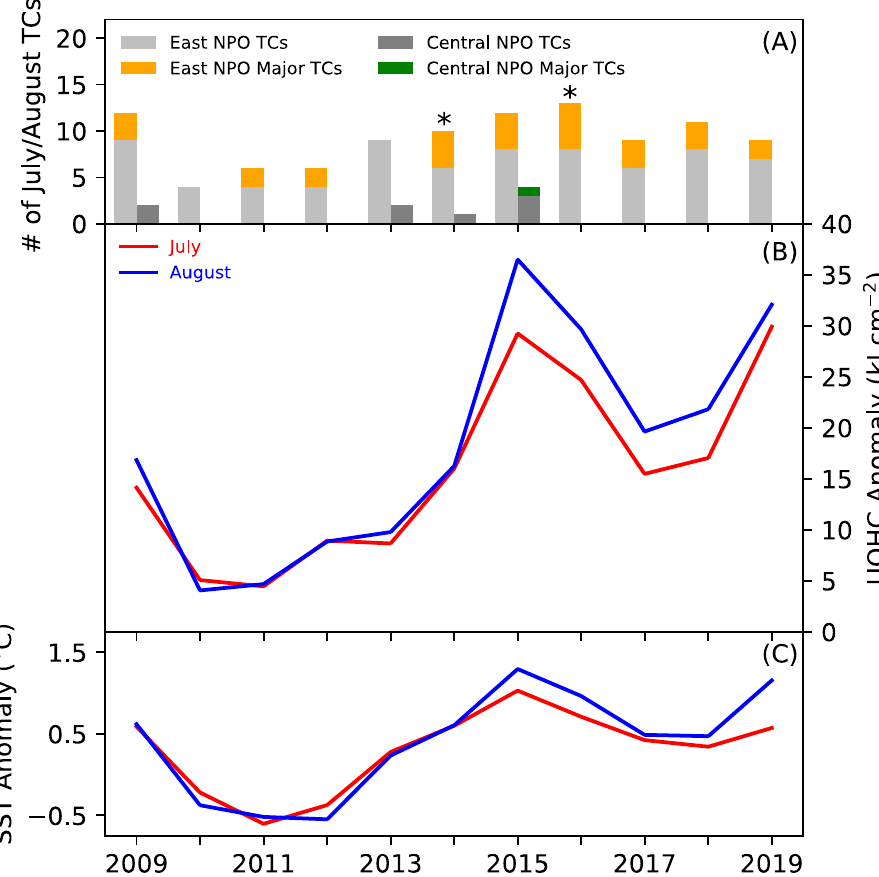
Figure 4. ( A ) July and August TC counts for 2009–2019, broken down by genesis in either the East NPO or the Central NPO, and by minor or major hurricane status. Stars indicate a Hawaiian landfalling TC in this timeframe. July and August monthly mean ( B ) upper ocean heat content (UOHC) anomalies and ( C ) sea surface temperature (SST) anomalies in the 10–20° N NPO cyclogenesis region